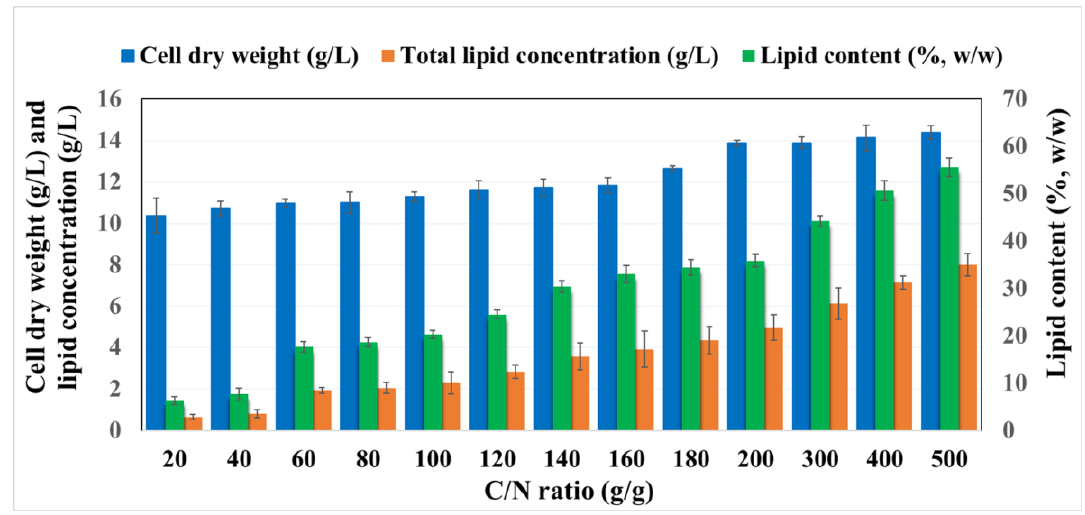
Figure 2. Effect of various C/N ratios (g/g) on the cell dry weight (g/L), lipid concentration (g/L) and lipid content (%, w / w ) of Rhodosporidium toruloides.